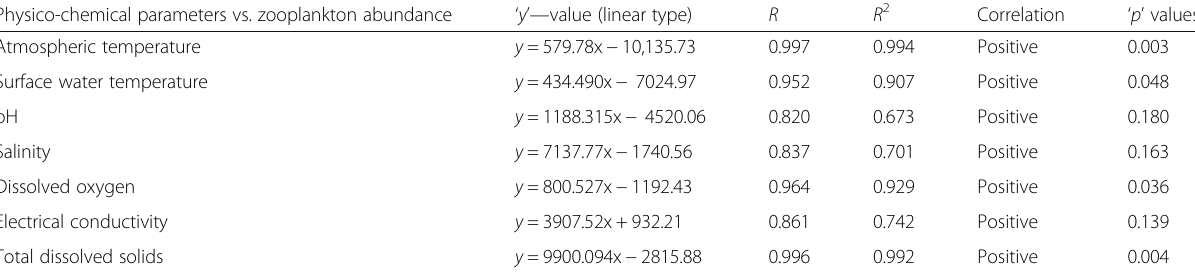
Table 4 The relationship between physico-chemical parameters and zooplankton abundance/population in the Ukkadam Lake during the study period (December 2011 – November 2012) Physico-chemical parameters vs. zooplankton abundance ‘ y ’— value (linear